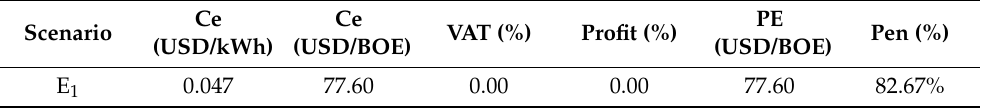
Table 19. Prices of the energy from the ST.